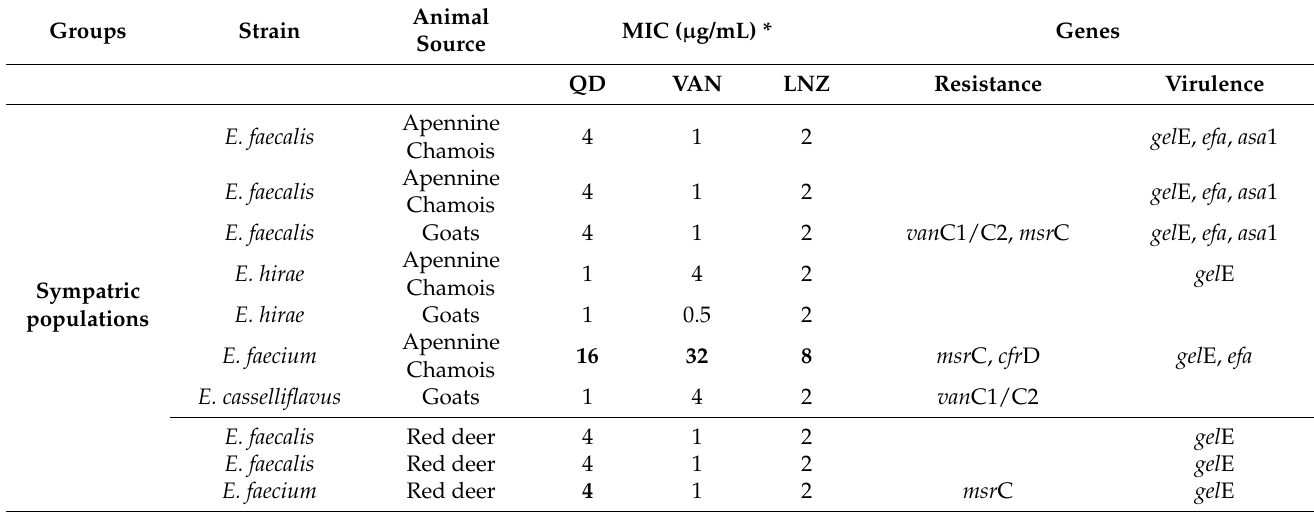
Table 1. Details of bacterial species, animal sources, MIC values, and genes detected in this study.